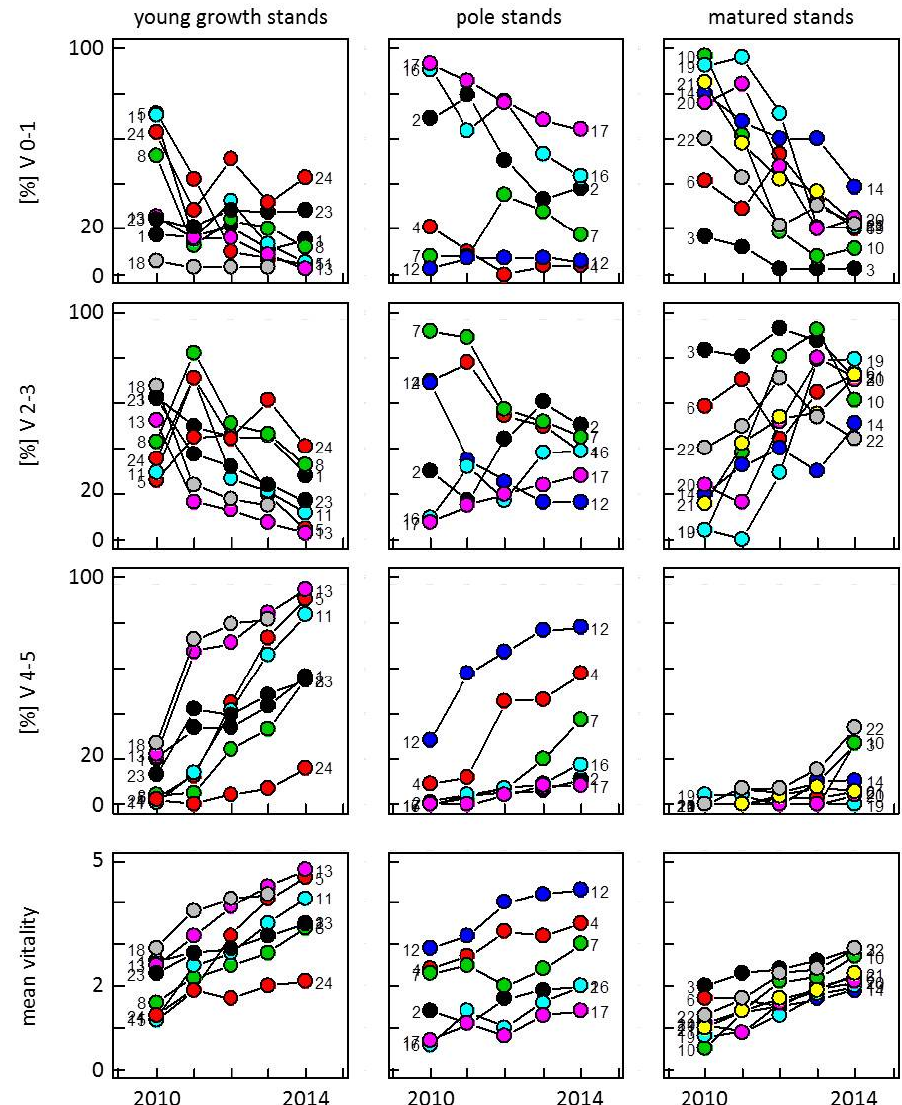
Figure 2. The amount of trees belonging to the vitality classes 0–1 (less affected), 2–3 (moderate symptoms) and 4–5 (dying or dead) is illustrated for young growth, pole- and matured stands from 2010 to 2014. The development of the mean vitality for each study site is shown at the bottom. Numbers indicate study sites (Table 1).